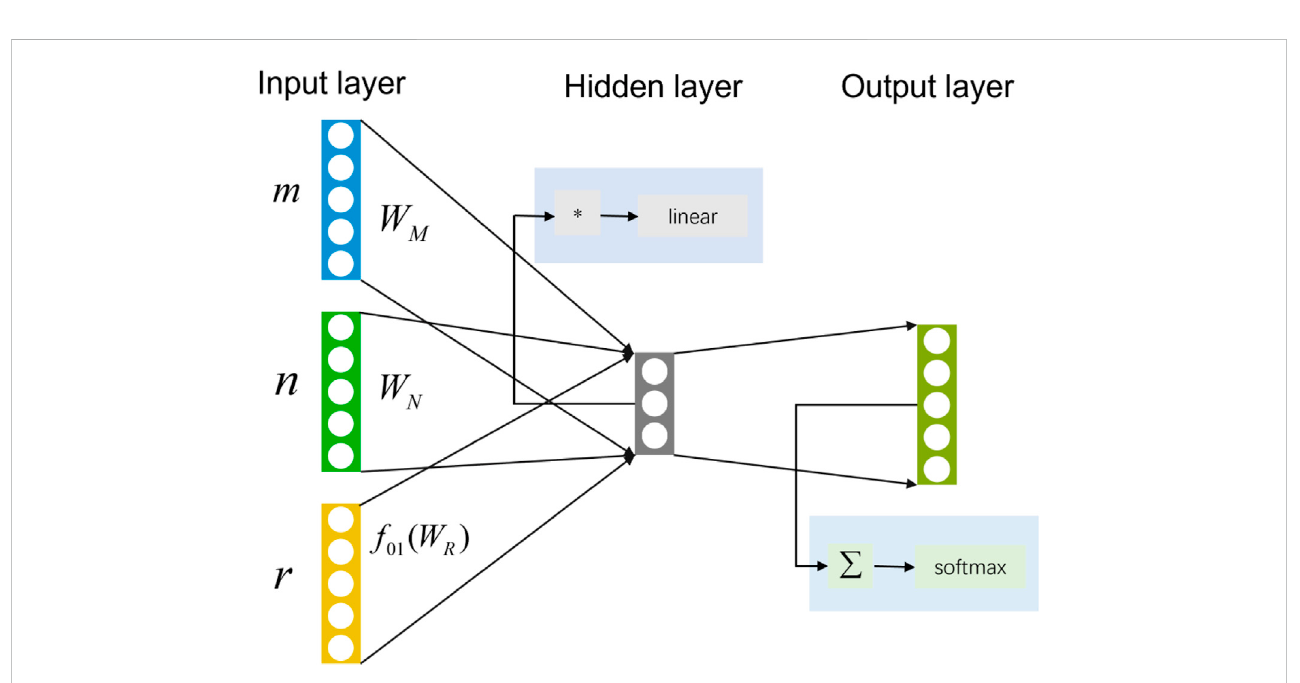
FIGURE 8 HIN2Vec NN model includes input layer, hidden layer and output